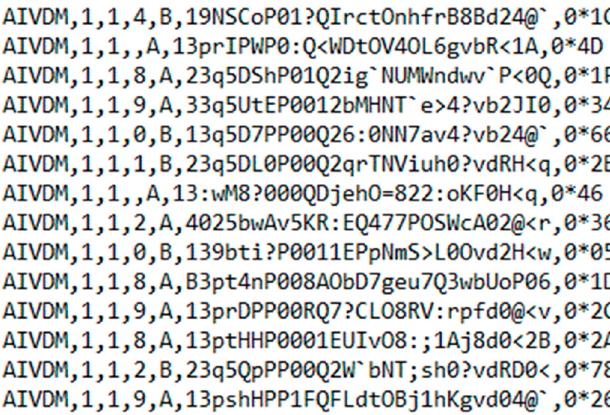
Figure 2. Extract from original AIS data registered by a shore-based station in the AIS-PL.